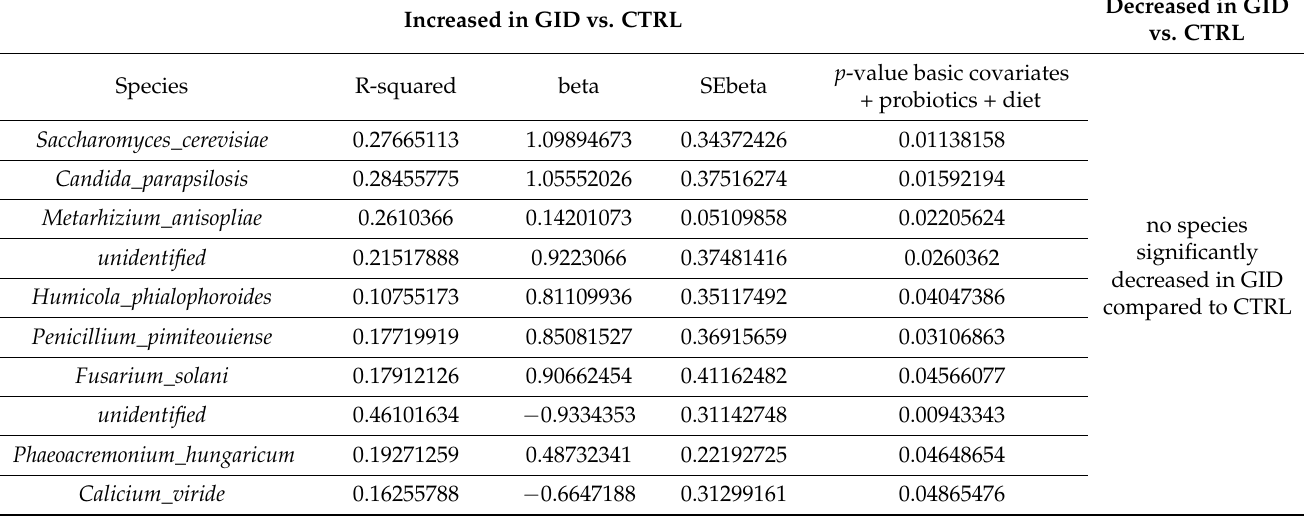
Table 9. Fungi in GID compared to CTRL at the species level. Increased in GID vs.